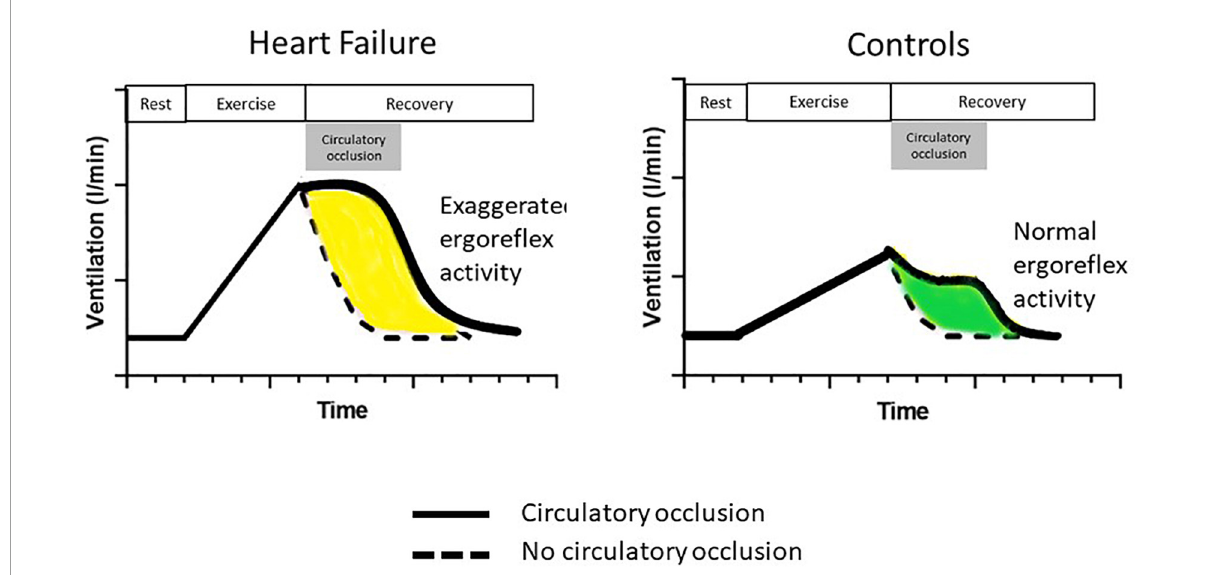
FIGURE2 The ergoreflex in chronic heart failure. Following handgrip dynamometer exercise to exhaustion, a cuff is either inflated around the exercising arm at peak exercise (solid line) or not (dotted line). The cuff is deflated after 3 min (end of circulatory occlusion in gray box). Compared to controls, patients with heart failure have an exaggerated ergoreflex response, resulting in greater ventilatory response to exercise. Their ventilatory response is maintained at the same level as maximum exertion throughout circulatory occlusion. Adapted from Piepoli et al.